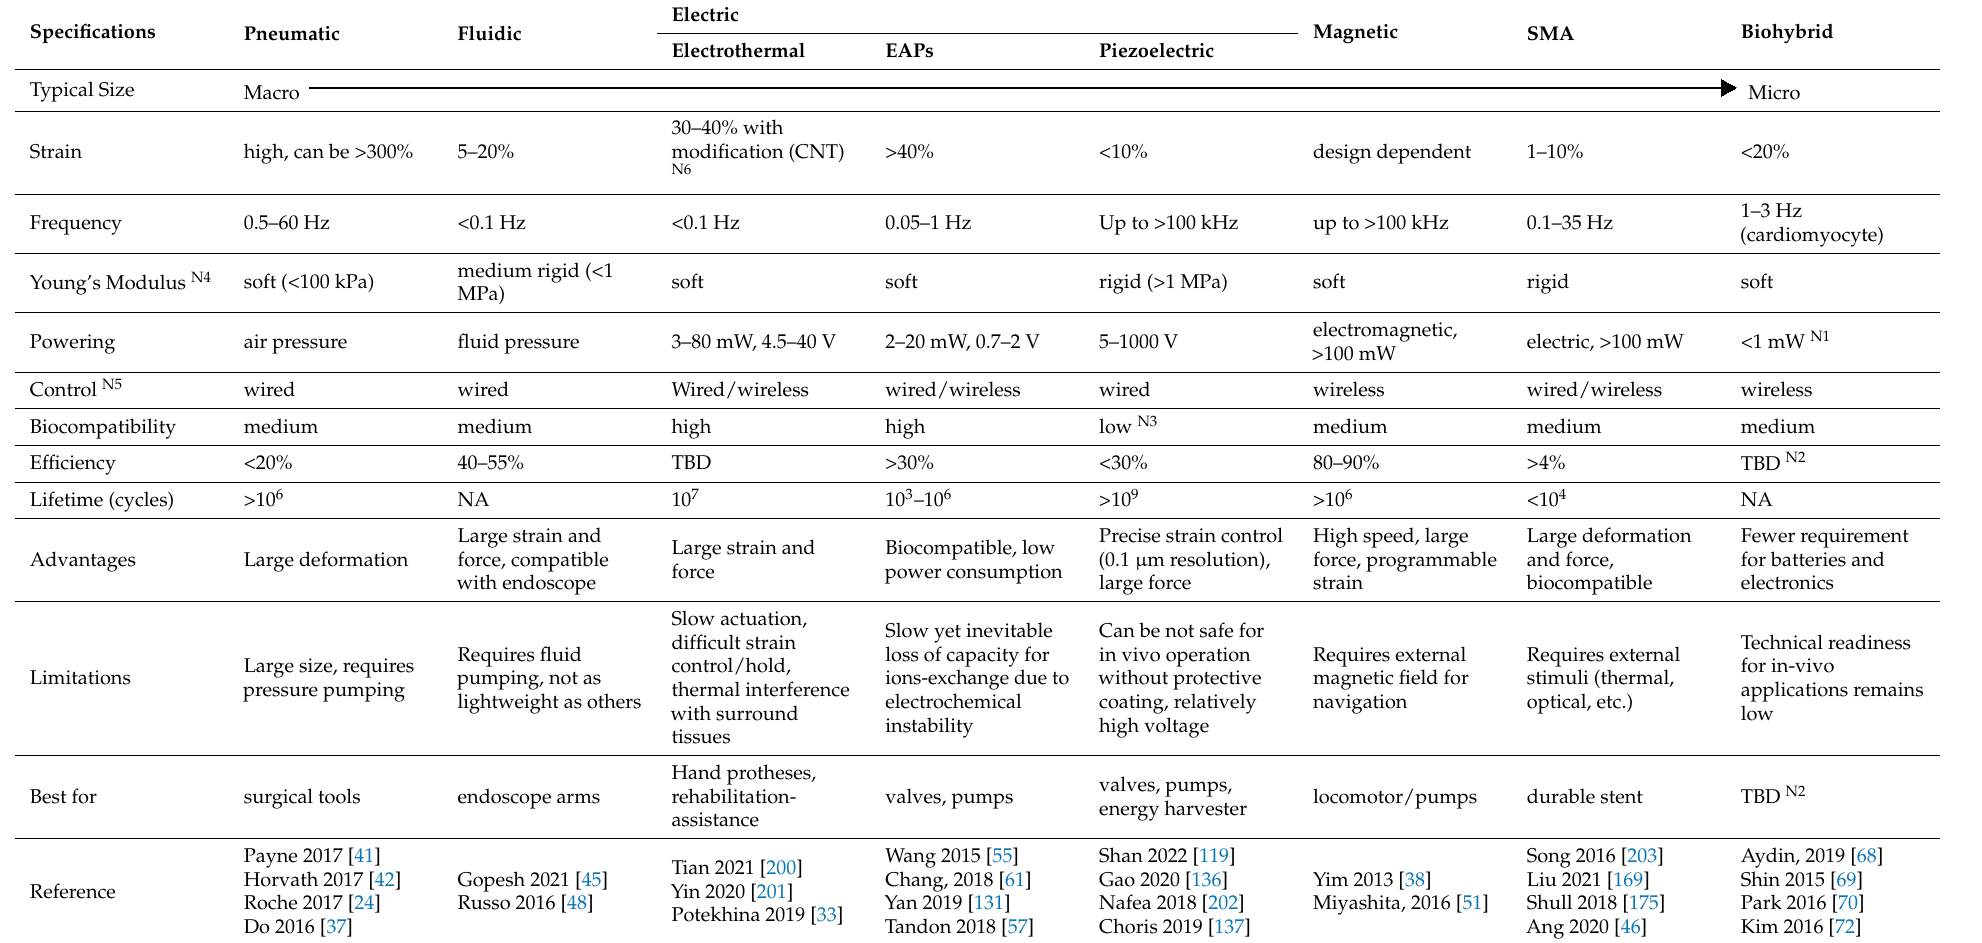
Table 1. Specifications of Different Types of In-body Actuators.